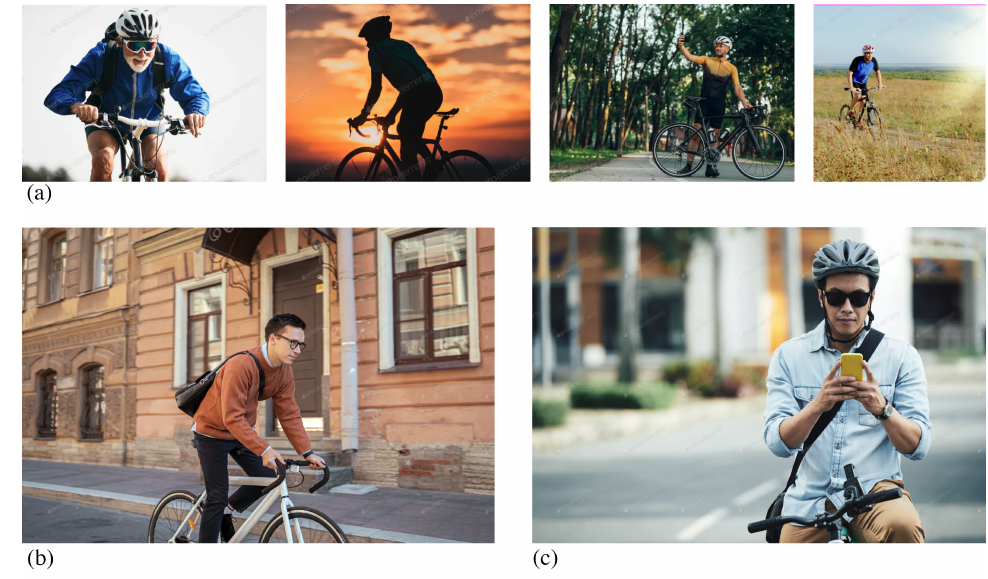
Figure 12. Calculation of soundness in the area of traffic